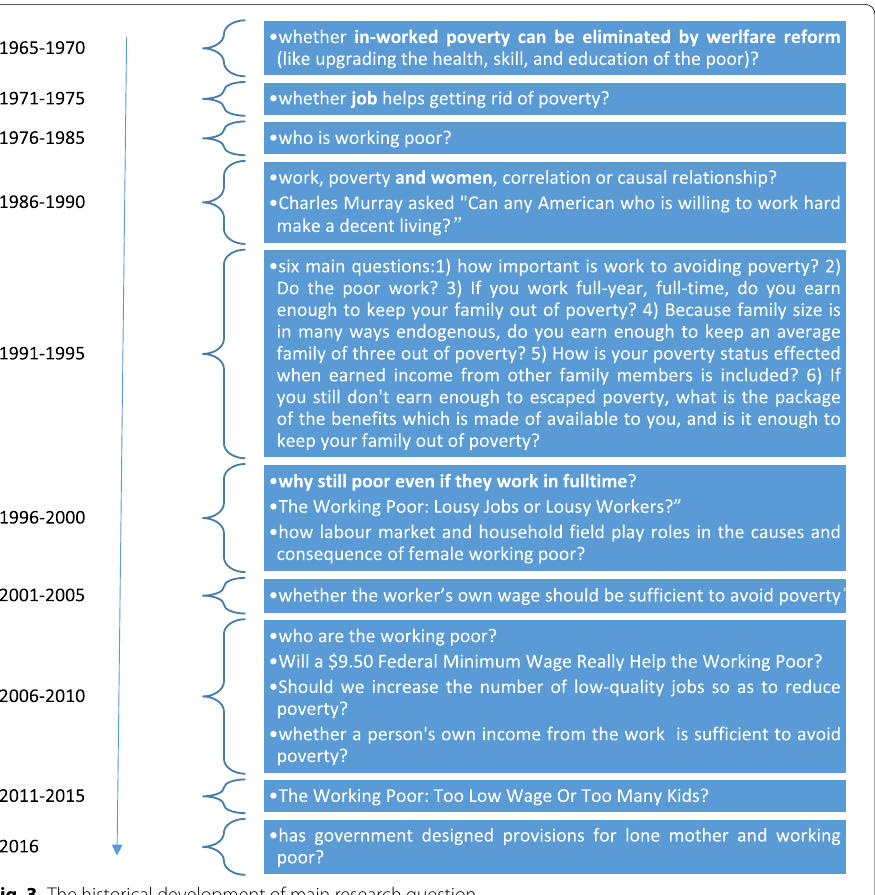
Fig. 3 The historical development of main research